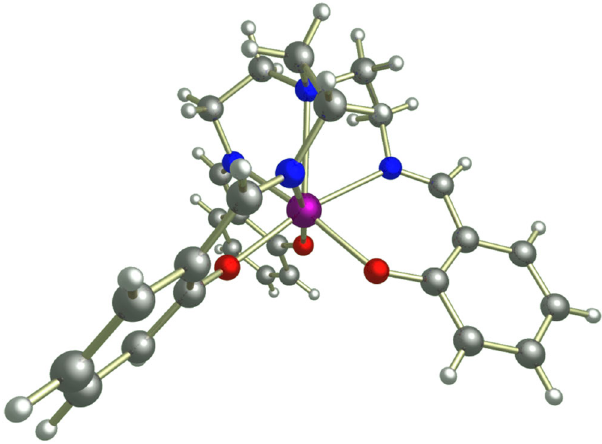
Fig. 1 Structure of [Yb(trensal)] (1) viewed perpendicular to the C 3 axis. Hydrogen = white, carbon = grey, nitrogen = blue, oxygen = red, ytterbium = purple.